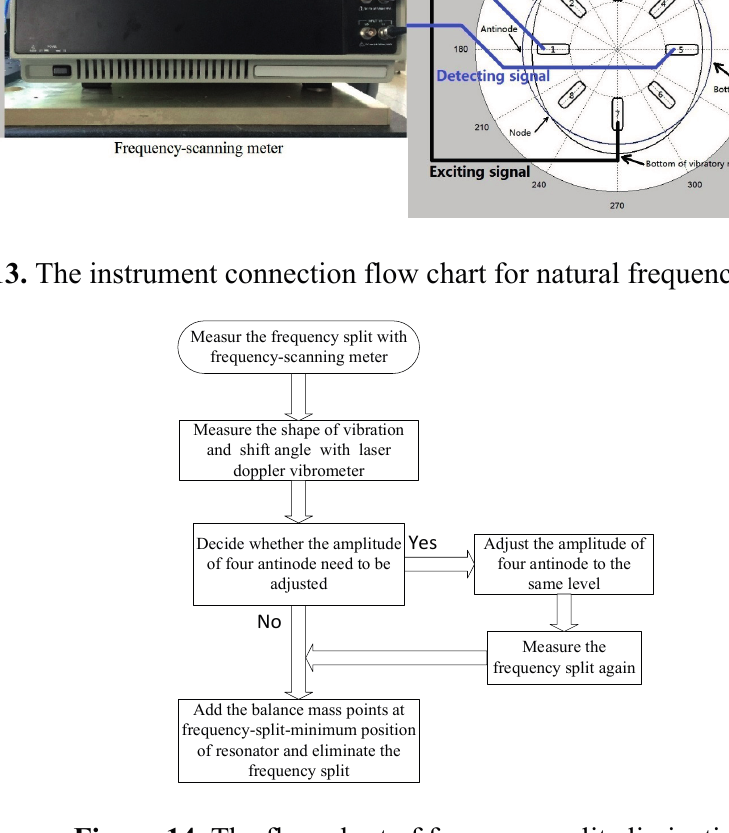
Figure 14. The flow chart of frequency split